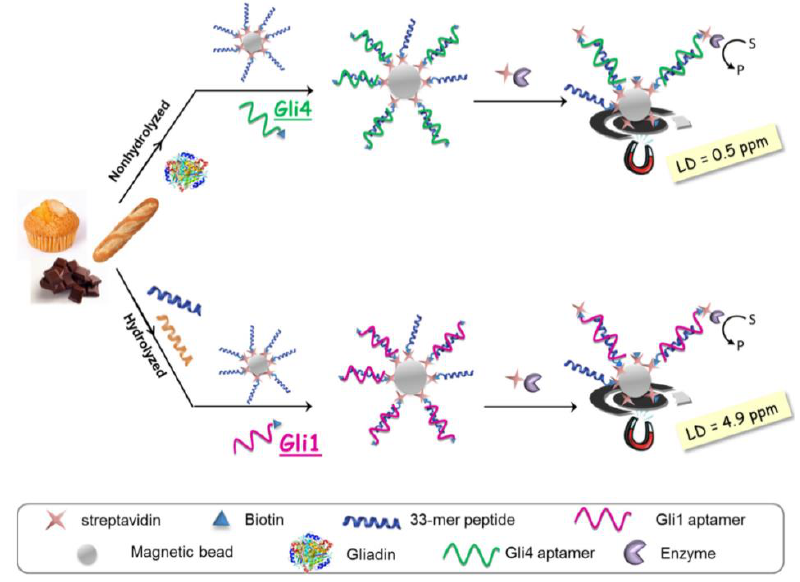
Figure 8. Principle of aptamer-based magnetoassays for gliadin determination in processed foods